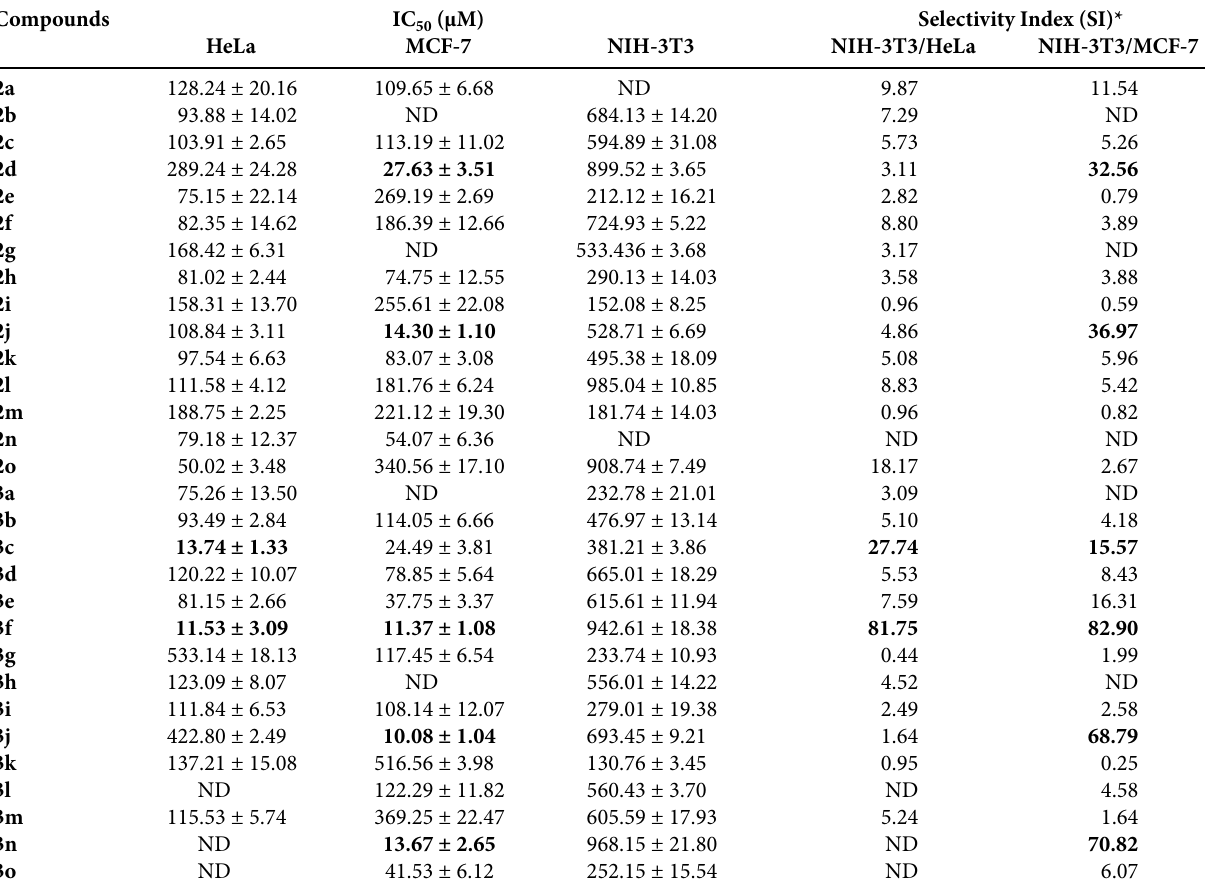
Table 1. The IC 50 values of synthesized pyrazoline derivatives Compounds IC 50